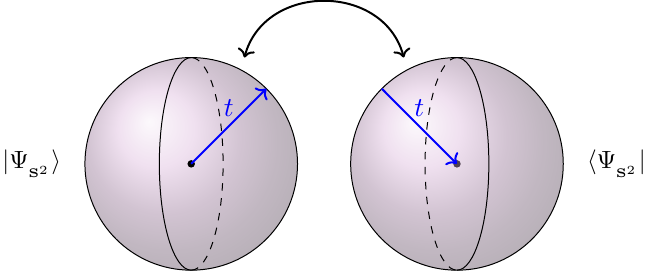
Figure 2 . Cutting S 3 along an S 2 provides two 3-balls B . The origin of one of the 3-ball corresponds to the origin of S 3 which can be viewed as t = (cid:0)1 . The origin of the other 3-ball corresponds to t = 1 . Canonical quantization should be viewed as radial quantization with time t running from the center of the left B to the boundary S 2 and then back down through the boundary of the right B down to its origin (as indicated by the arrows). This helps prepare the state j (cid:9) conjugate h (cid:9) j S 2